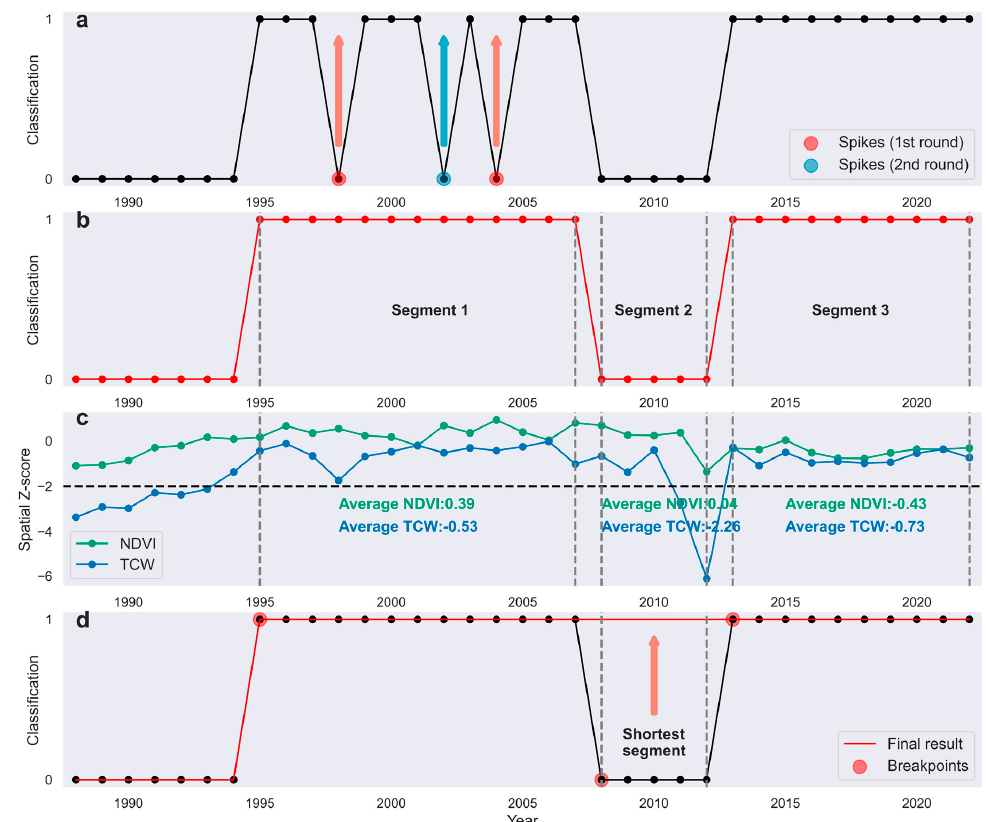
Figure 4. Annual classification results corrected by TCC-CS over a selected site (latitude: 22.385418°N, longitude: 89.646424°E). Spikes in the ( a ) raw classification results were iteratively corrected first. ( b ) Temporal segments were then corrected by their ( c ) average z-score of NDVI and TCW, generating the black line in ( d ). Since the breakpoints were more than 2, the shortest segment was corrected to its opposite state. Eventually, a mangrove gain event was detected in 1995.